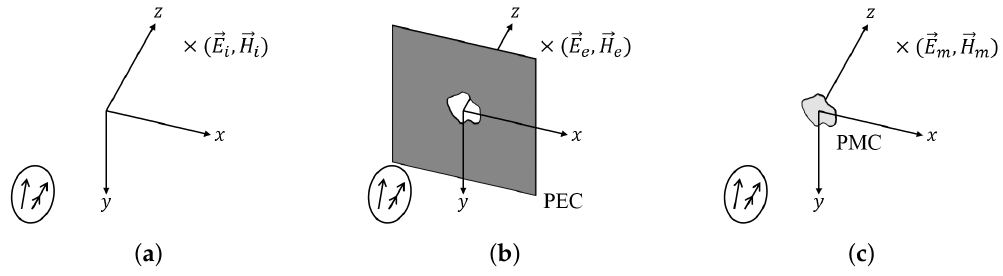
Figure 14. Babinet’s principle: ( a ) free space, ( b ) perfect electric conductor (PEC) screen, and ( c ) perfect magnetic conductor (PMC) plate.